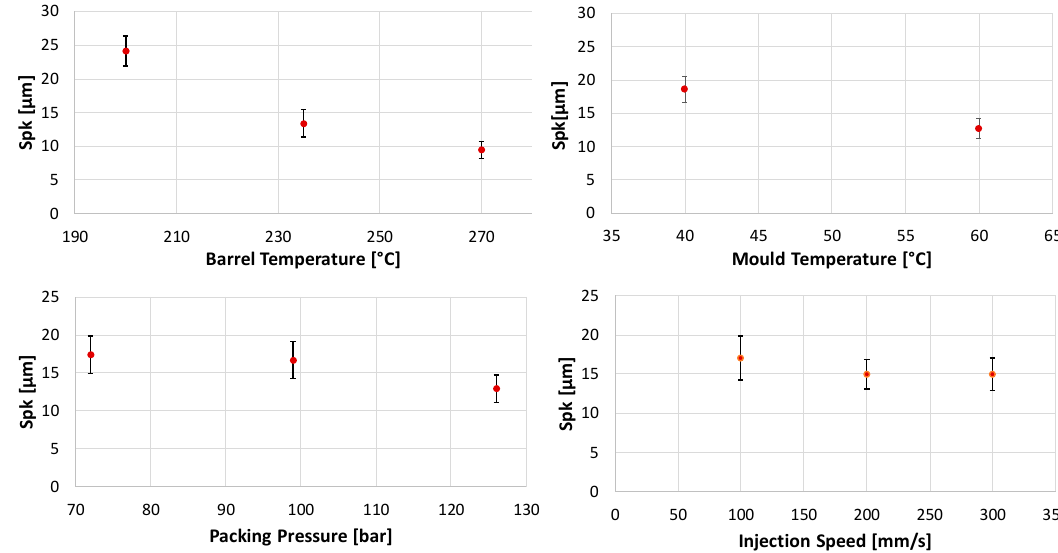
Figure 7. Main Effect of chosen parameters on the roughness parameter Spk: main effects of barrel temperature—T b on Spk ( top left ); main effects of mould temperature—T m on Spk ( top right ); main effects of packing pressure—P p on Spk ( bottom left ); and main effects of injection speed—V i on Spk ( bottom right ).